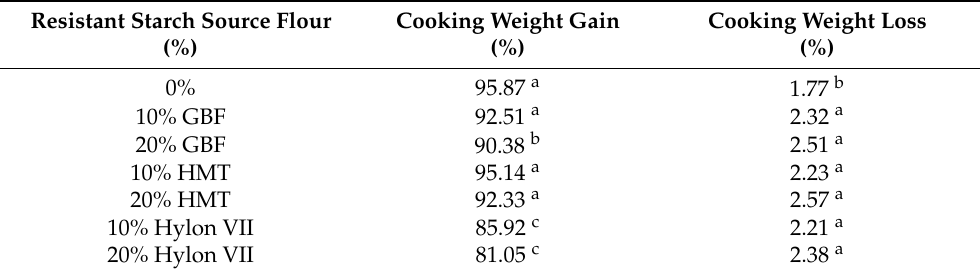
Table 5. The cooking weight gain and cooking weight loss of noodles containing different proportions of resistant starch source